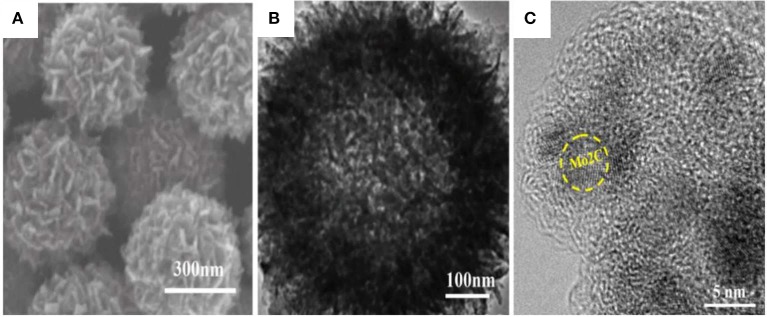
(A) The SEM, (B) TEM, and (C) HRTEM images of Mo2C@C.